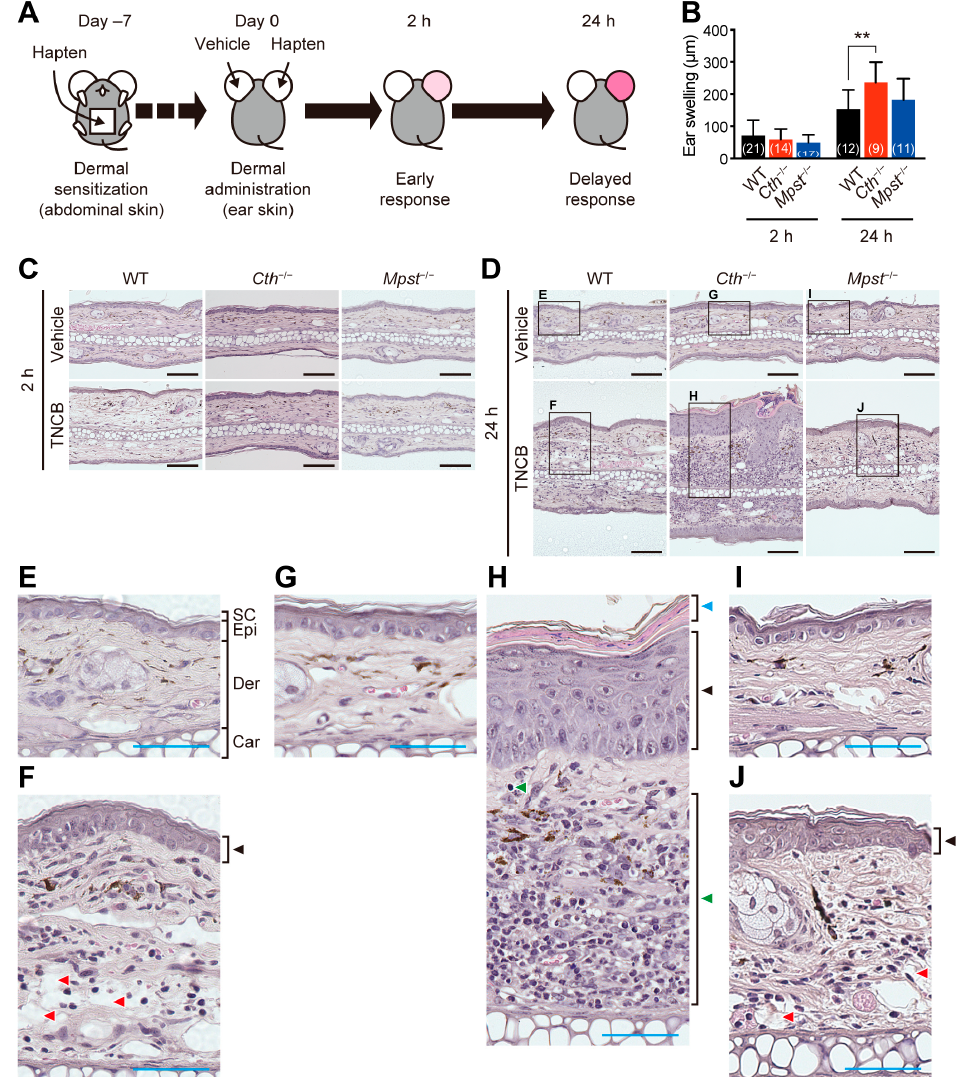
Figure 2. Trinitrochlorobenzene (TNCB)-induced contact dermatitis. ( A ) Experimental design. Adult male wild-type (WT), CTH-deficient ( Cth –/– ), and MPST-deficient ( Mpst –/– ) mice were sensitized on the skin and then (7 days later) challenged with TNCB on single ear (another ear with the vehicle) to examine Th1-type allergic responses. ( B – J ) Increased thickness of the ear (ear swelling = thickness difference between the TNCB-treated right ear and the vehicle-treated left ear) at 2 h and 24 h after the challenge ( B ) and their typical section images of HE-stained sagittal sections ( C , D ) with magnified images ( E – J ). Data are the mean ± SD (sample numbers). Differences are significant between the groups at each point by a one-way analysis of variance (ANOVA) with Tukey’s multiple comparison test; ** p < 0.01 ( B ). Black bars indicate 100 µ m ( C , D ), and blue bars indicate 50 µ m ( E – J ). SC, stratum corneum; Epi, epidermis; Der, dermis; and Car, cartilage ( E ). Black arrowheads indicate TNCB-induced acanthosis ( F , H , J ); blue and green arrowheads indicate parakeratosis and immune cell infiltration, respectively ( H ); and red arrowheads indicate spongiosis ( F , I ). Immunostaining of ear sections revealed the most massive infiltration of CD4 ‐ posi ‐ tive T cells (Figure 3A,C), CD8 ‐ positive T cells (Figure 3B,D), and myeloperoxidase (MPO) ‐ positive neutrophils (Figure 3A,B,E) in Cth − / − mice, compared to WT and Mpst –/– mice. Acute allergic responses (within 2 h) were not observed with oxazolone treatment, although the levels of their delayed responses (at 24 h) were comparable to those with TNCB and equivalent among the three genotypes (Figure 4A). HE staining revealed sim ‐ ilar levels of acanthosis, dermal spongiosis, and immune cell infiltration in the three gen ‐ otypes (Figure 4B–H).